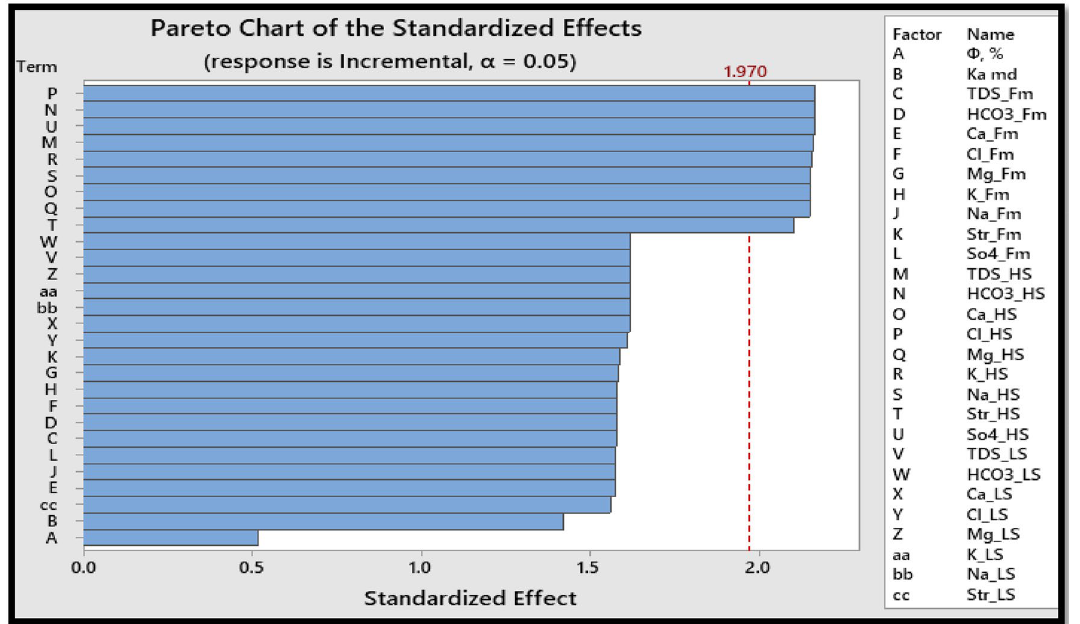
Fig. 10 Pareto chart using the datasets (without considering clay properties) of the secondary stage